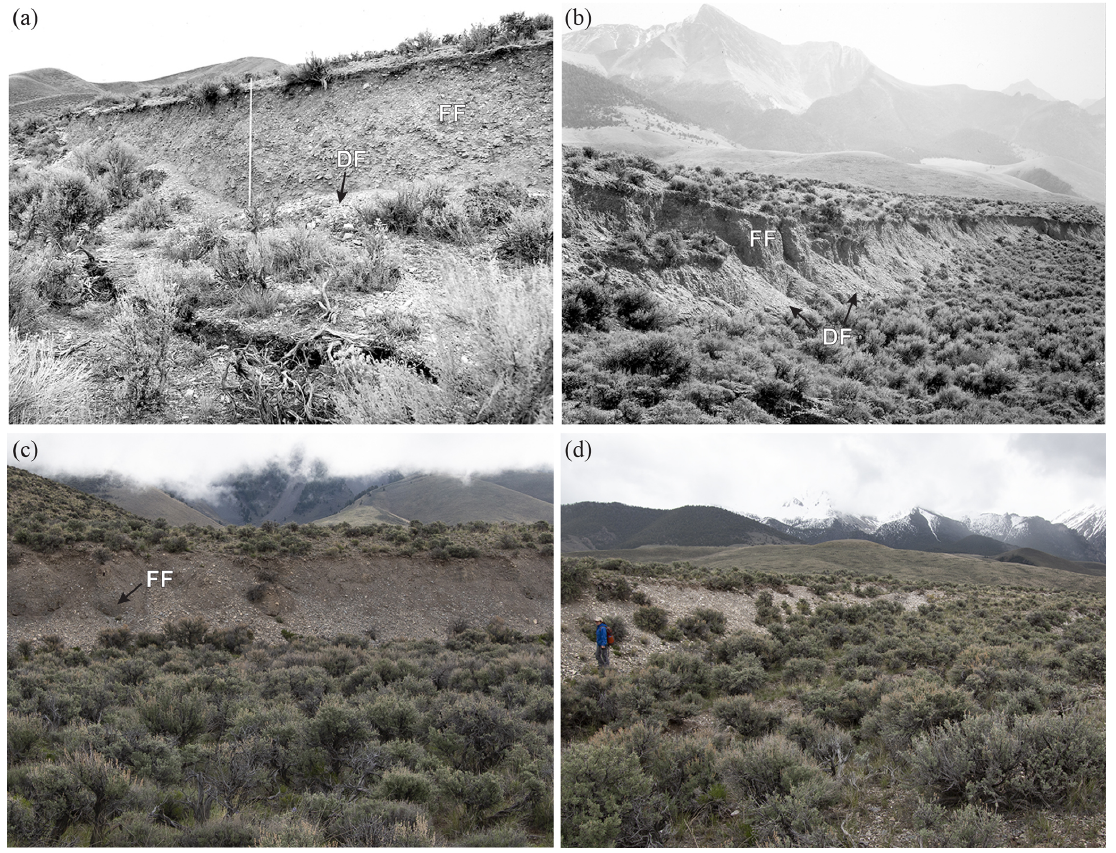
Figure 1. Fig. 1. Illustration of the surface expression of a colluvial-wedge-forming environment. (a, b) ∼ 2–3m high surface rupture associated with the 1983 M 6 . 9 Borah Peak, Idaho, earthquake. Photographs show initial debris facies (DF) colluvium deposited along the base of the fault scarp and exposed fault free face (FF). The rod in (a) is 2.8m high; the photographs were taken near Doublespring Pass road in 1983 and are available at https://library.usgs.gov/photo/#/?terms=Borah%20Peak (last access: 10 October 2021). (c, d) Similar fault scarps near Doublespring Pass road photographed in 2015. The person in (d) is ∼ 1 . 5m tall. Photographs (c, d) taken in May 2015 by Christopher DuRoss.